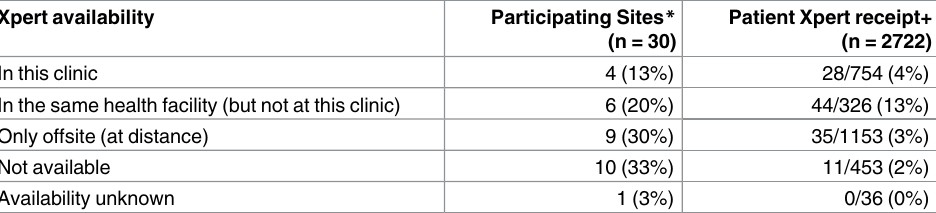
Table 2. Xpert availability at participating sites.